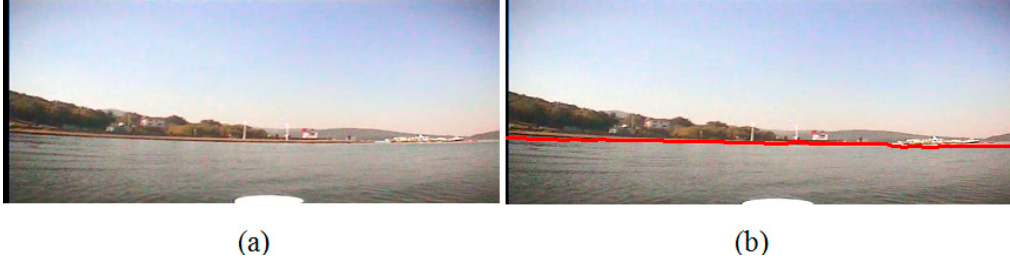
Figure 15. Waterline detection of a far bank. ( a ) The image before our detection; ( b ) The image after our detection.